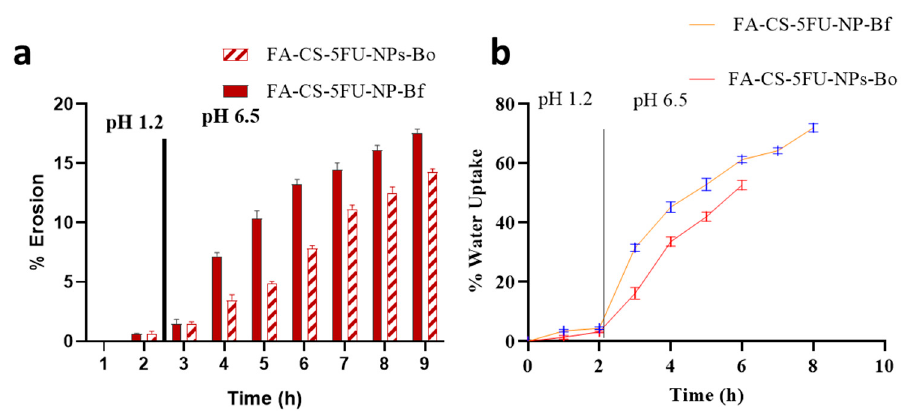
Figure 8. ( a ) Erosion of FA-CS-5FU-NP-Bf and FA-CS-5FU-NP-Bo; ( b ) water-uptake index of FA-CS-5FU-NP-Bf and FA-CS-5FU-NP-Bo.